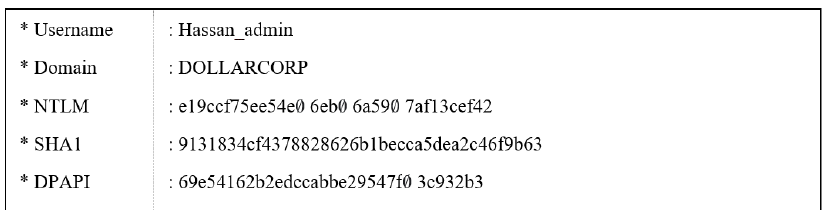
Figure 10. Admin NTLM Hash Dumped Successfully.